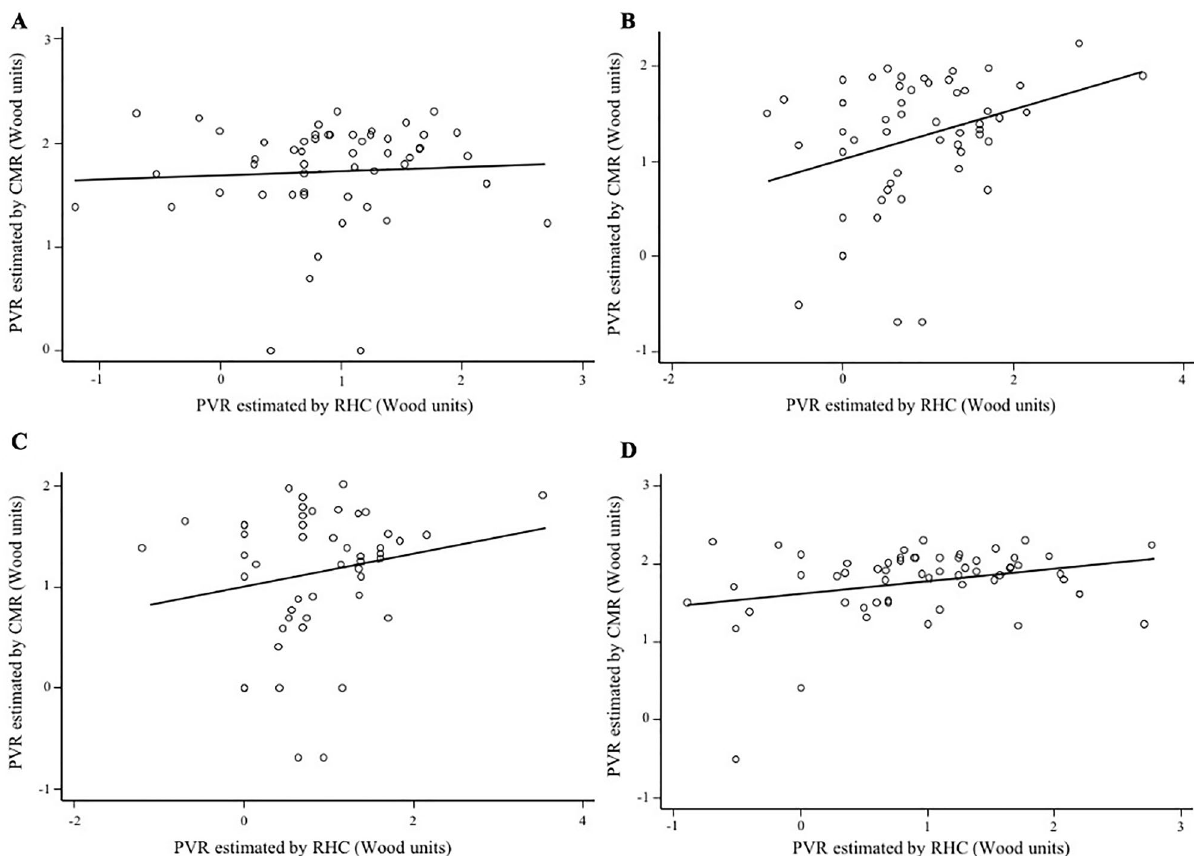
Figure 2. Subgroup correlations between pulmonary vascular resistance quantified by right heart catheterization and pulmonary vascular resistance assessed by cardiovascular magnetic resonance. ( A ) Left ventricular ejection fraction less than 30%. ( B ) Left ventricular ejection fraction more or equal to 30%. ( C ) Depressed right ventricular ejection fraction. ( D ) Preserved right ventricular ejection fraction. CMR cardiovascular magnetic resonance, PVR pulmonary vascular resistance, RHC right heart